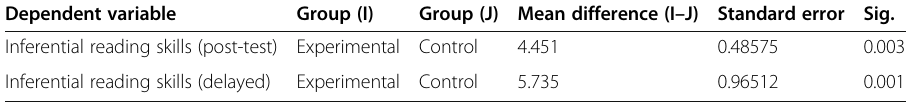
Table 7 Pairwise comparisons of the results in both groups based on the post-test and delayed post-test scores Dependent variable Group (I) Group (J) Mean difference (I – J) Standard error